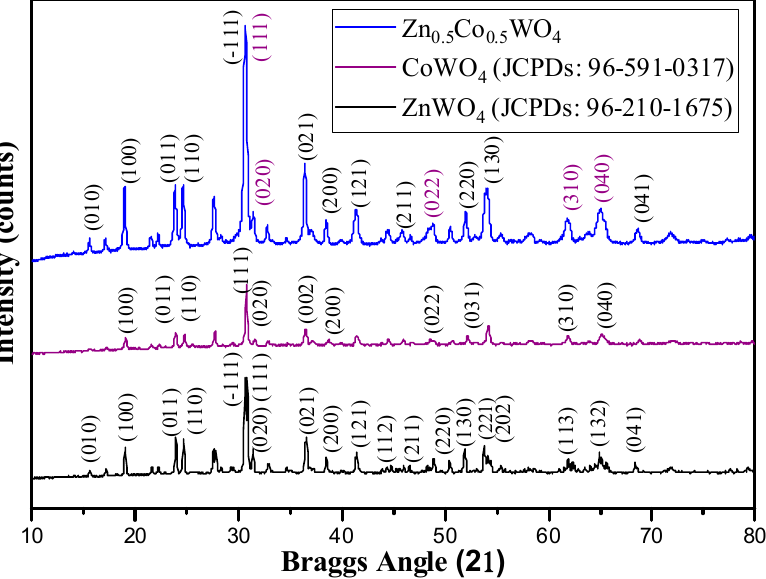
Figure 2. X-ray diffraction pattern of ZnWO 4 , CoWO 4, and Zn 0.5 Co 0.5 WO 4 calcined at 600 ℃ . Further information about crystallite size and dislocation density; Scherrer’s equa- tion was taken into consideration [28]. 0 .9 λ D = β co sθ